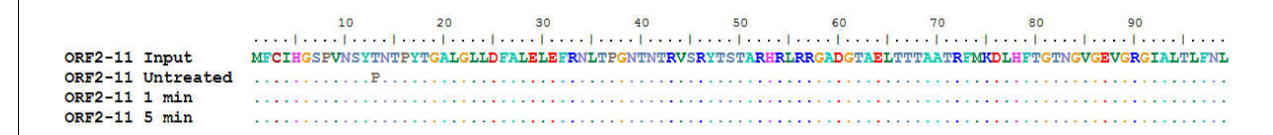
FIGURE 4 | Amino acid sequence alignment of the N domain of the capsid protein (ORF2). The sequences for input, the untreated, treatment at 600 MPa for 1 min hold time and 600 MPa for 5 min hold time were aligned using Mega6 software and translated into amino acid sequences using BioEdit software.